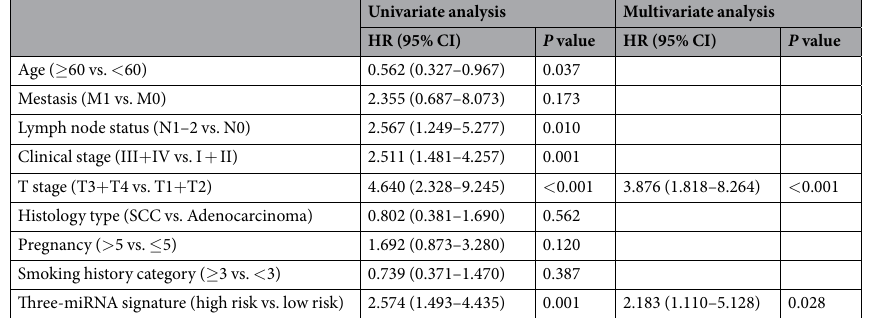
Table 3. Univariate and multivariate Cox regression analysis in CC